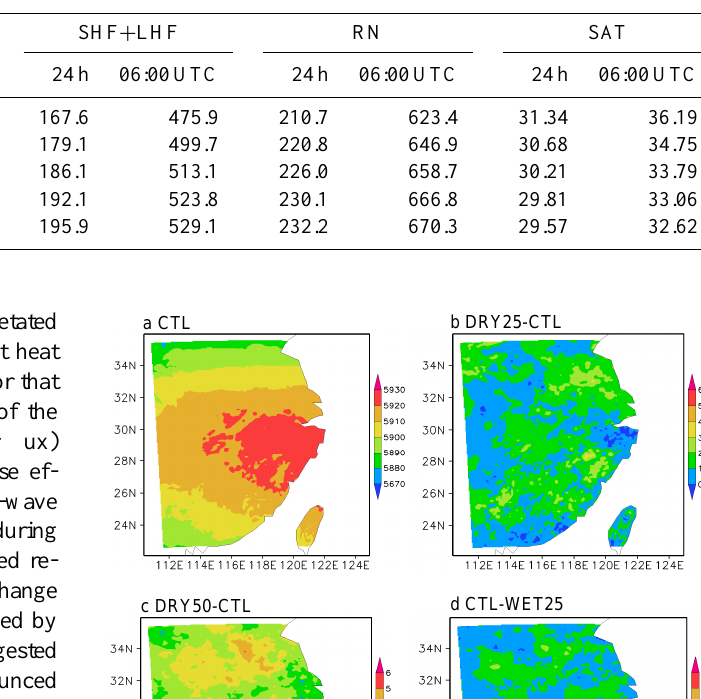
Table 1. The 10-day means of 24h averaged and 06:00UTC sensible heat flux (SHF; Wm − 2 ) , latent heat flux (LHF; Wm − 2 ) , LHF plus SHF, net radiation (RN; Wm − 2 ) and surface air temperatures (SAT; ◦ C) for the five groups of simulations.